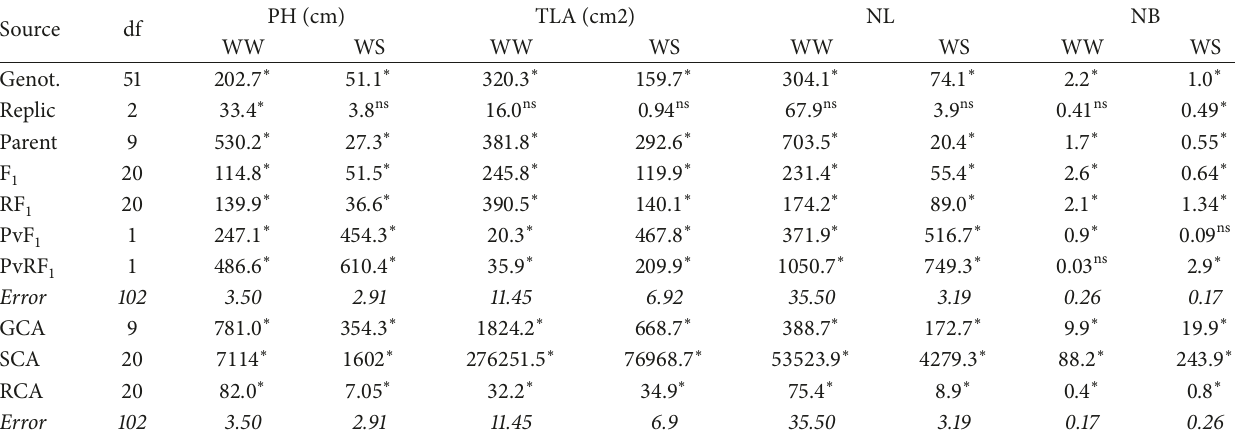
Table 2: Analysis of variance of diallel cross for morphological characteristics of cowpea crosses in water-stressed (WS) and well-watered (WW) environments.